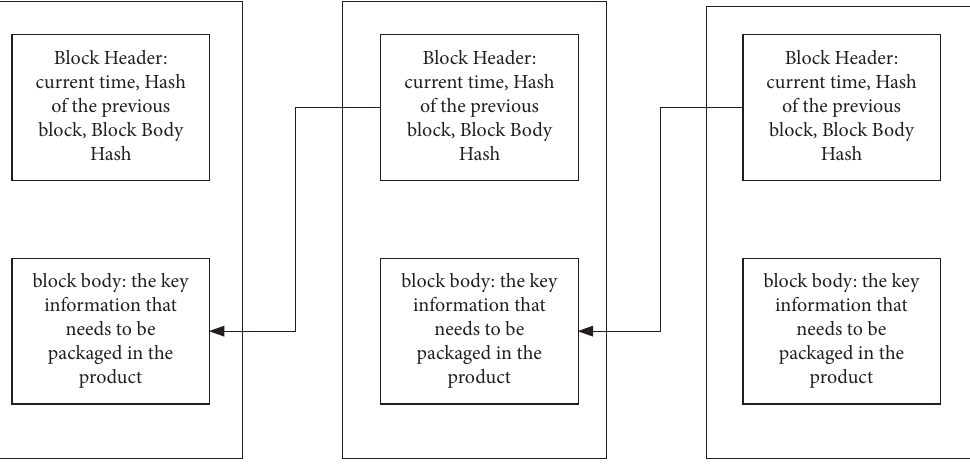
Figure 1: Block connection schematic.